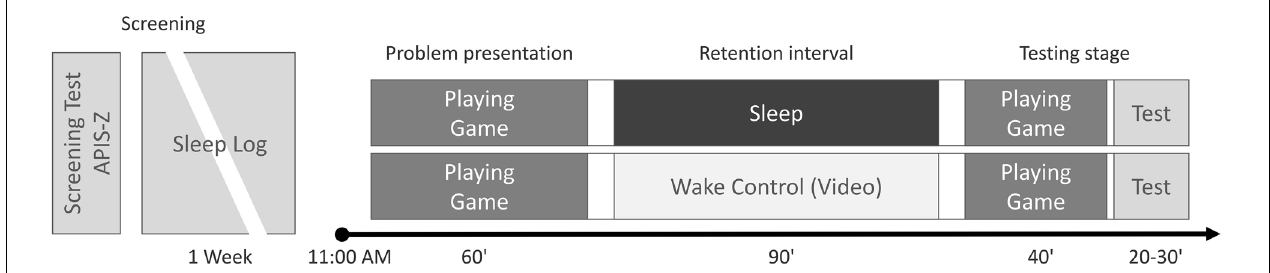
FIGURE 1 | Study protocol. One week before the experimental day, participants filled out the questionnaires (screening test and APIS-Z battery) and started sleep log. On the experimental day, they were acquainted with the problem in the form of a computer game first; then, they took a nap (sleep group) or watched videos (waking group). In the testing stage, participants finished the game and tried to solve the problem (filling out the final